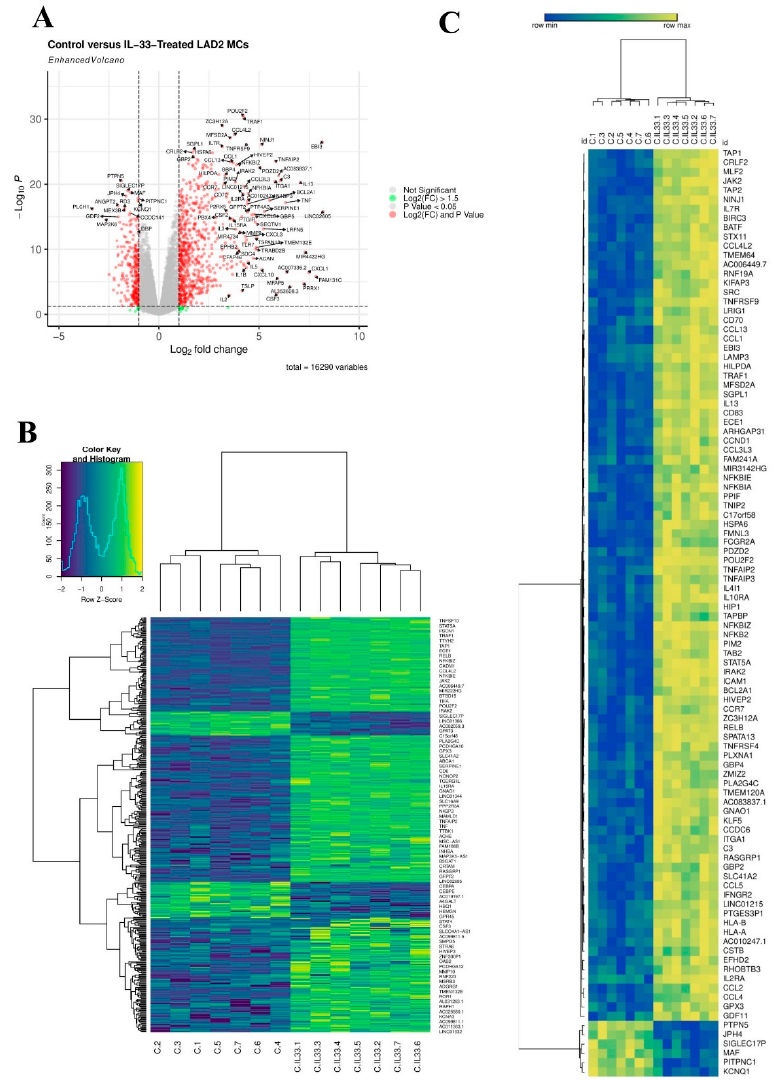
Figure 1. IL-33 induced 414 DEGs in MCs. ( A ) , volcano plot of DEGs 6 h post IL-33 (10 ng/mL) treatment, n = 7. ( B ), Heatmap of all 414 DEGs 6 h post IL-33 (10 ng/mL) treatment, n = 7. ( C ), Hierarchal clustering heatmap of top 100 most significant DEGs 6 h post IL-33 (10 ng/mL) treatment, n = 7.